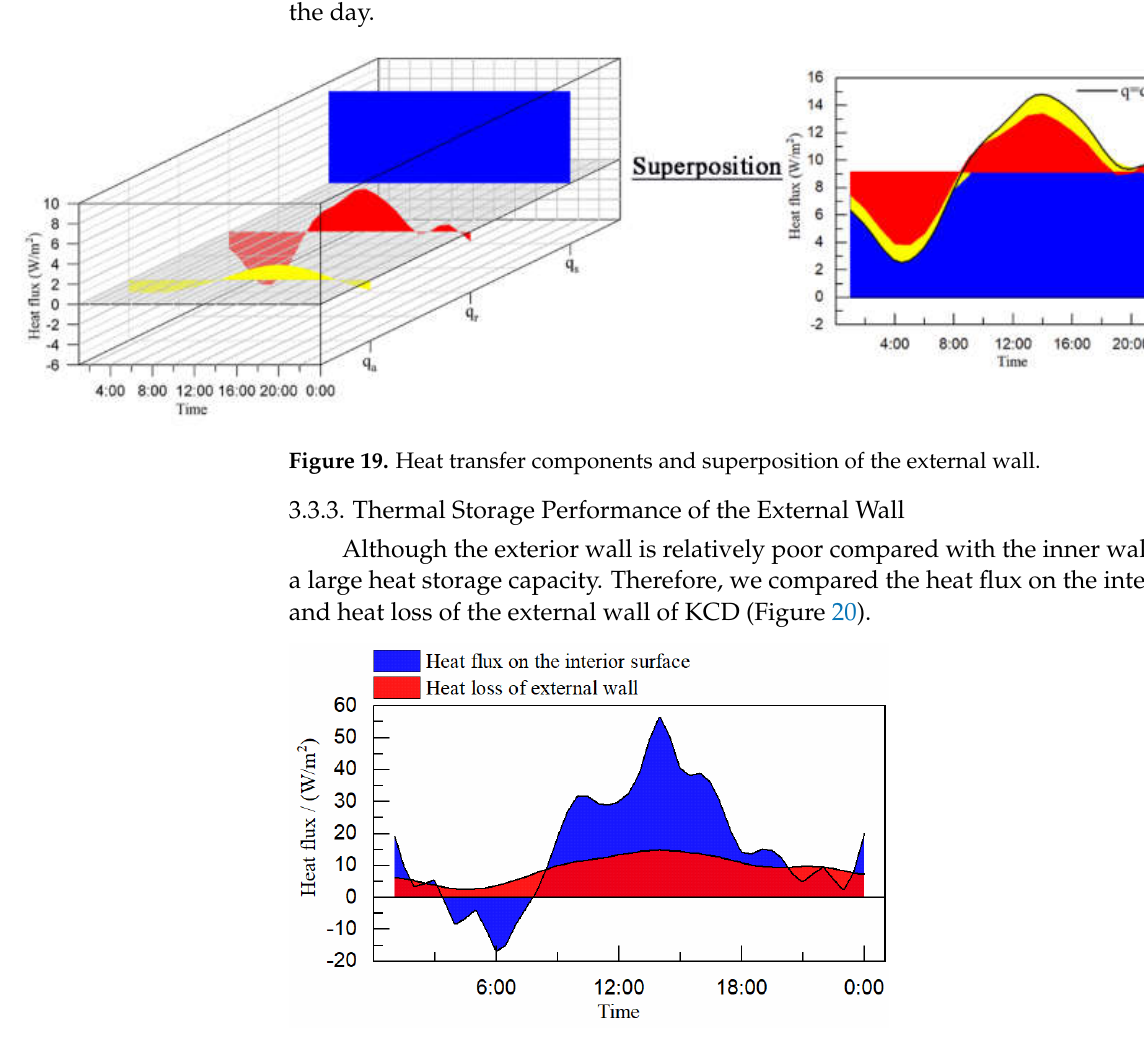
Figure 20. Heat flux on the interior surface and heat loss of external wall.